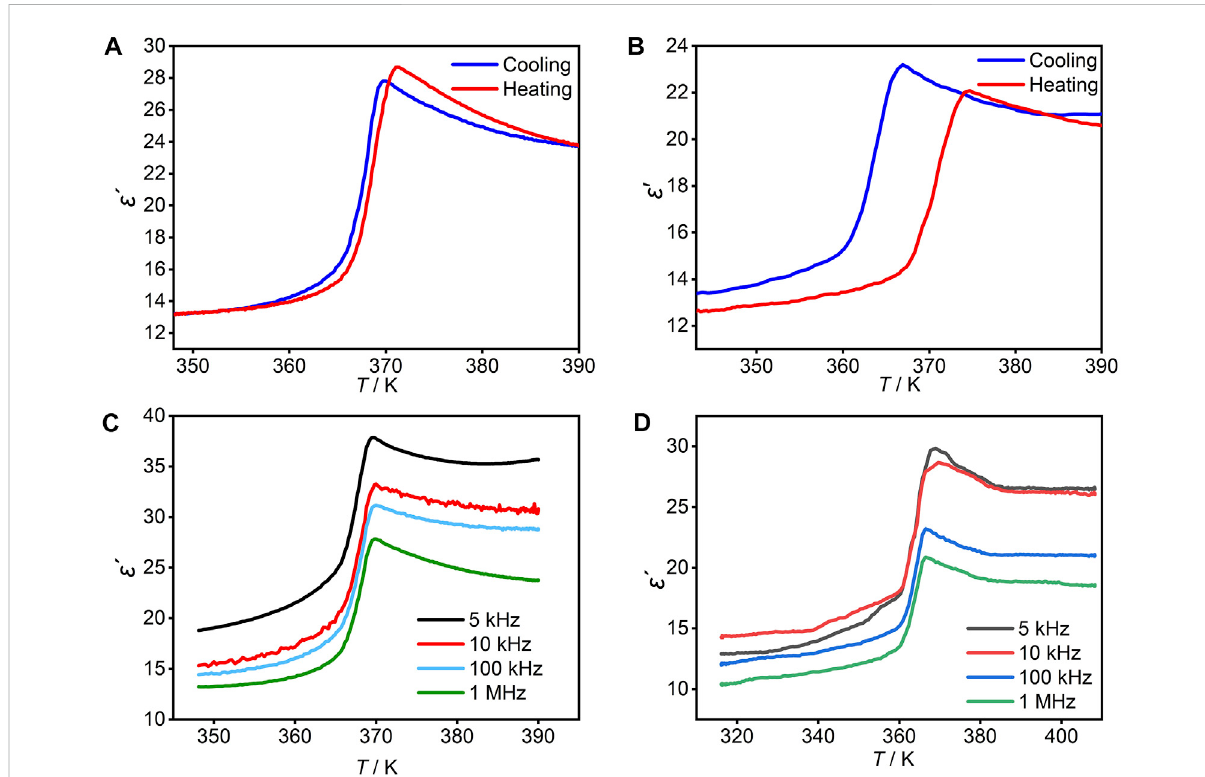
FIGURE 4 Temperature-dependence of the dielectric constant real part ( ε ′ ) of 1 (A) at 100 kHz and 2 (B) at 1 MHz with powder samples, respectively. Temperature-dependence of the dielectric constant real part ( ε ′ ) of 1 (C) and 2 (D) during heating at different